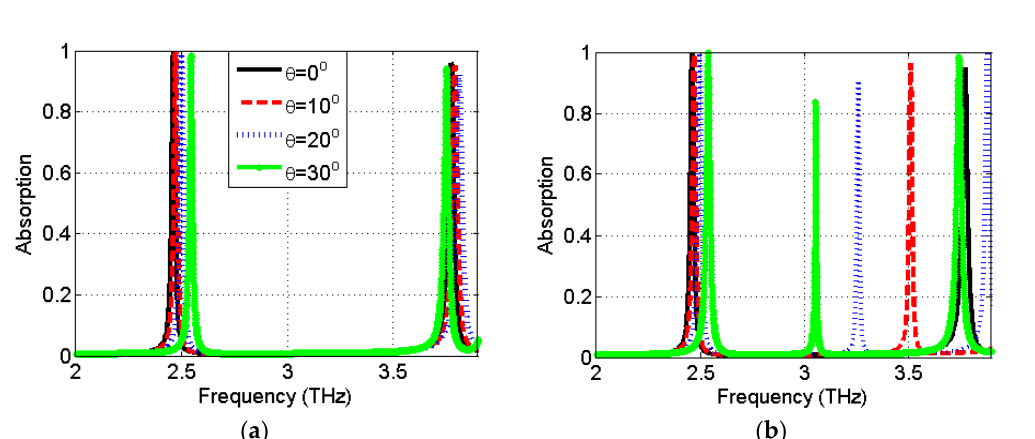
Figure 8. Absorption spectra of the proposed absorber with parameters presented in Table 1 obtained by HFSS as a function of incident angle and frequency for ( a ) TE and ( b ) TM polarization.